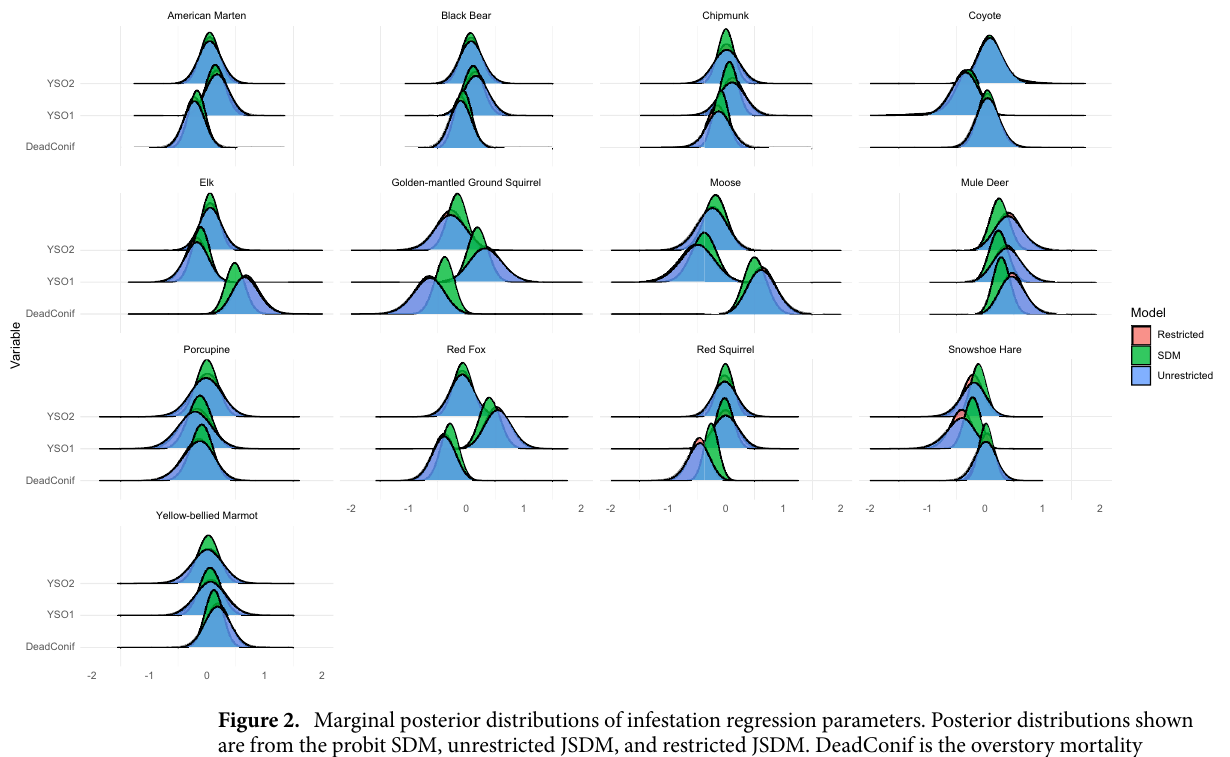
Figure 2. Marginal posterior distributions of infestation regression parameters. Posterior distributions shown are from the probit SDM, unrestricted JSDM, and restricted JSDM. DeadConif is the overstory mortality percentage, a proxy for severity of bark beetle infestation. YSO1 is the linear effect of the number of years since a site was infested with bark beetles. YSO2 is the quadratic effect. Figure created in R 4.1.2 62 .